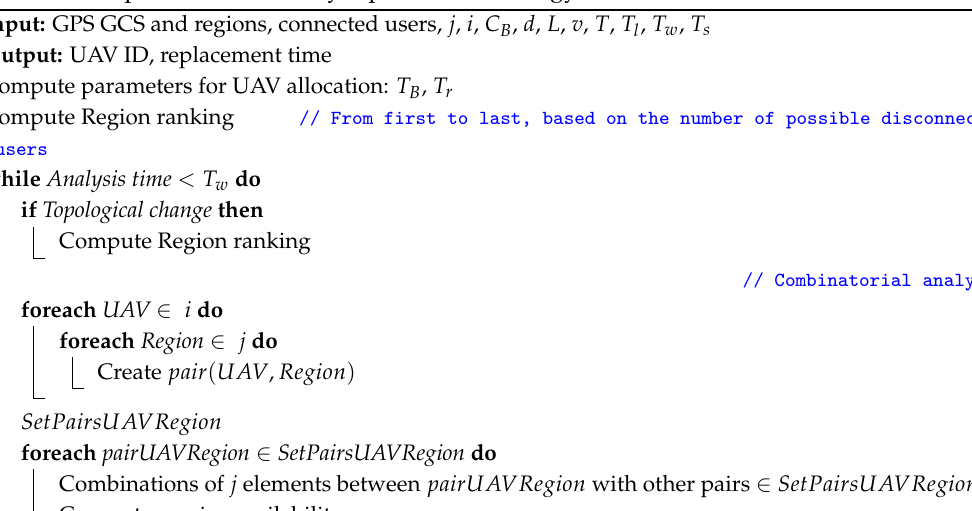
Algorithm 1: Optimal UAV battery replacement